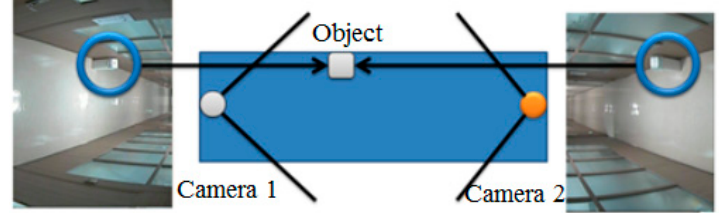
Figure 1. Images viewed from two neighboring indoor surveillance cameras.